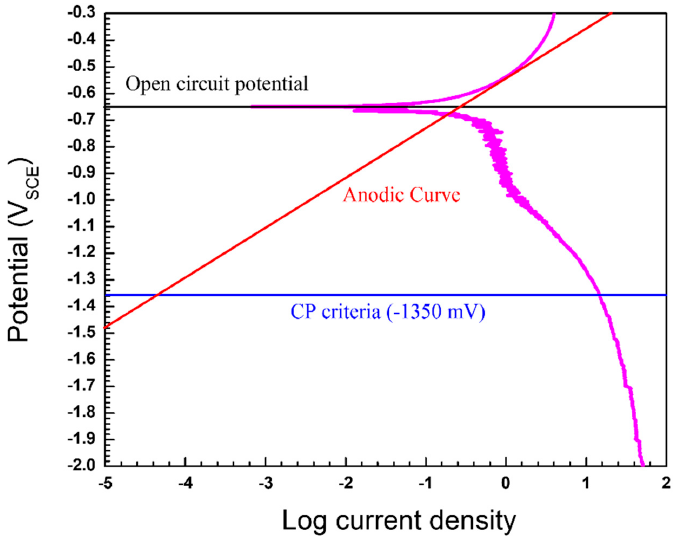
Figure 3. Potentiodynamic polarization curves in the synthetic groundwater at 80 °C. Table 4. Results of Potentiodynamic Polarization Test at 80 °C in the Synthetic Groundwater. Corrosion Potential (E corr , mV SCE